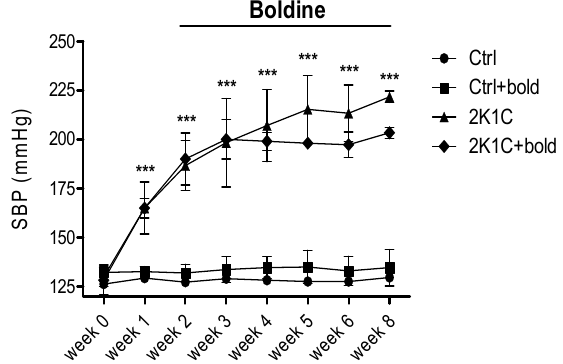
Figure 3. Boldine does not reduce SBP in 2K1C hypertensive rats. Once 2K1C animals became hypertensive (pressure ≥ 180 mmHg; week 2), a randomly selected group of animals ( n = 5) received the oral treatment with boldine for six weeks (from week 0 to week 6). Pressure was measured weekly until the day of sacrifice. Bars represent the mean ± SE. The differences were evaluated by analysis of variance followed by the Tukey post-hoc test. *** p < 0.001 vs. Ctrl ( n = 3/all groups).